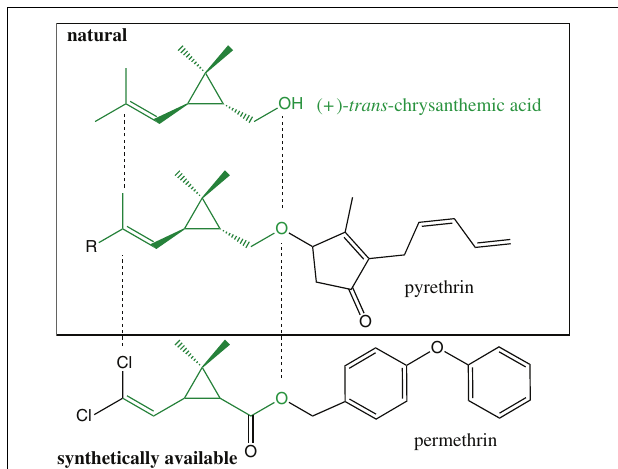
FIGURE 2 | Structure similarity of permethrin, pyrethrins, and chrysanthemic acid (chrysantemic moiety colored in